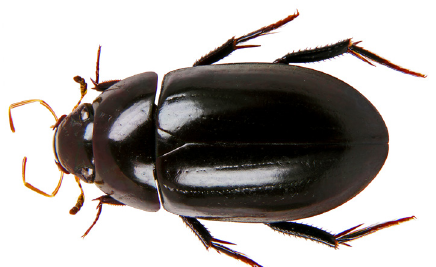
Figure 22. Hydrobiomorpha perissinottoi Bilton, 2016 18.5 mm, iSimangaliso Wetland Park, Eastern Shores (site 22), February 2015 DT Bilton, MS Bird & R Perissinotto leg.